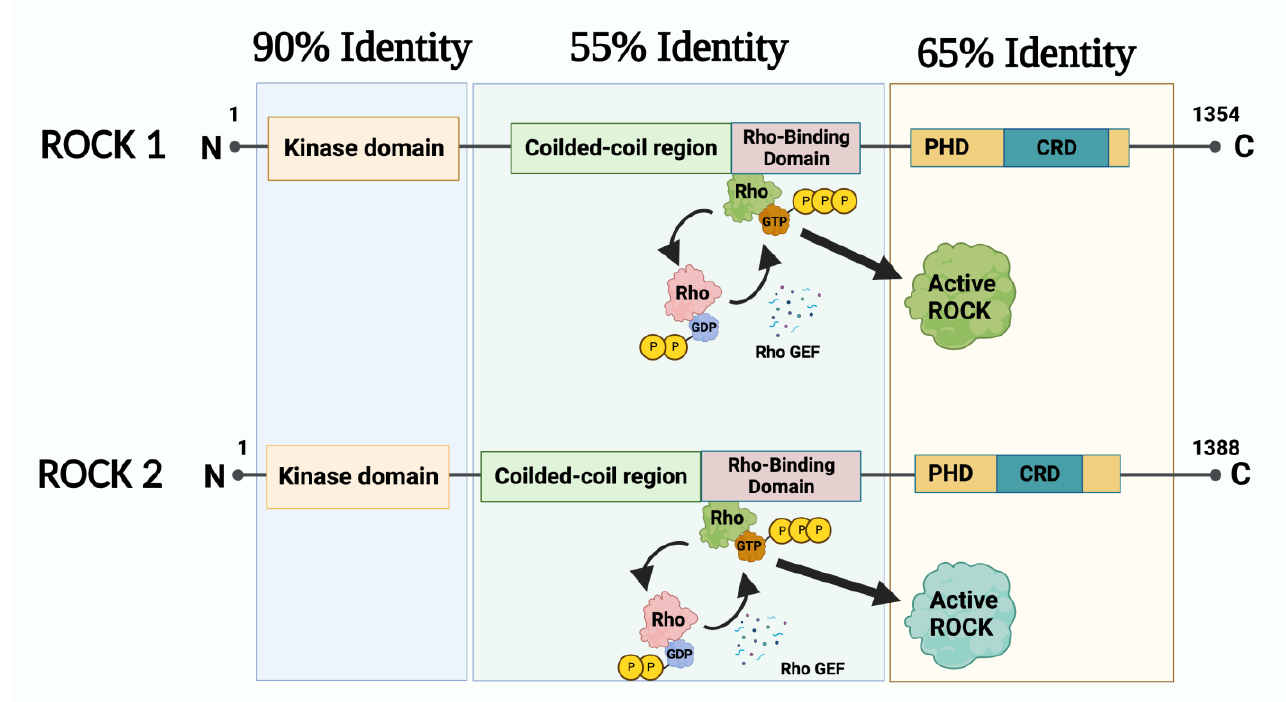
Figure 1. Molecular structure of ROCK 1 and ROCK 2. They are similar and both contain a kinase domain, coiled-coil region, rho-binding domain, putative pleckstrin homology domain (PHD) and cysteine-rich domain (CRD). Rho GEF = Rho guanine nucleotide exchange factor. Created with BioRender.com.